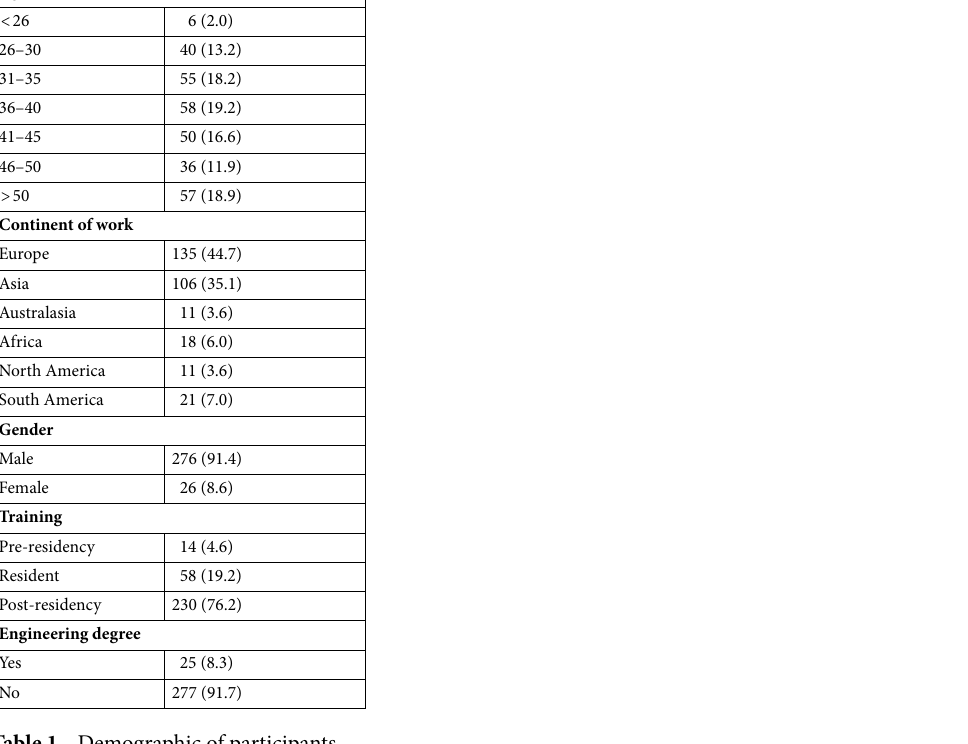
Table 1. Demographic of participants.